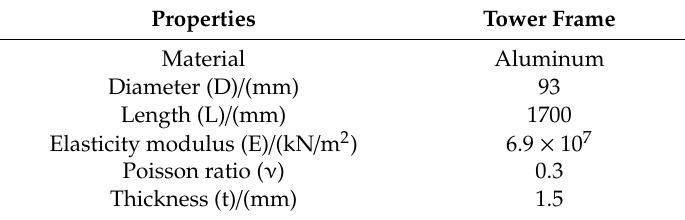
Table 3. Properties of model tower frame.